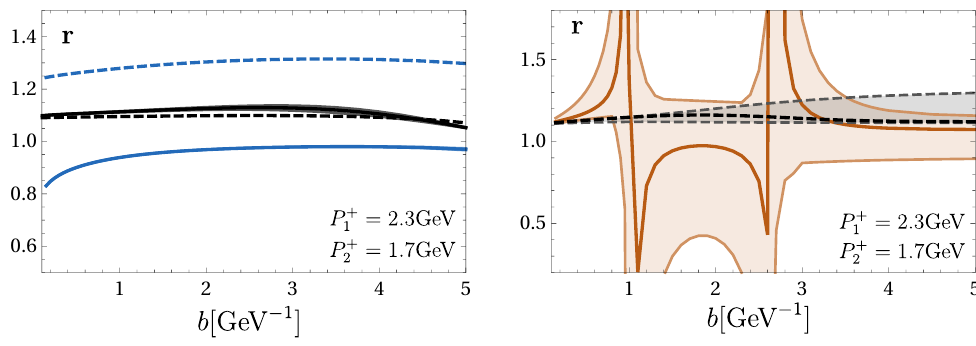
Figure 2 . (left) The factor r computed for d-quark unpolarized TMDs in the proton (blue) and pion (black), using the phenomenological extractions [12, 35]. The solid line (with an uncertainty band, due to the extraction uncertainties) is the result for the direct evaluation (2.20). The dashed line is the result of the perturbative computation (2.21) with the function M shown in figure 3. (right) The factor r was computed for the d-quark Sivers function in the proton, using the phenomenological extraction [36]. The orange line (with an uncertainty band due to the extraction uncertainty) presents the direct evaluation (2.20). The black line is the result of perturbative computation (2.21), and the function M is shown in figure 3. The Sivers function is not sign-definite, which produces diverging uncertainty bands for the ratio.